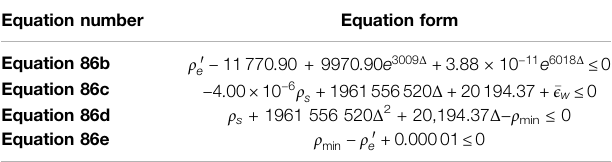
TABLE 4 | Constraints of Eq. 86 using the parameters of Table 3 . Equation number Equation